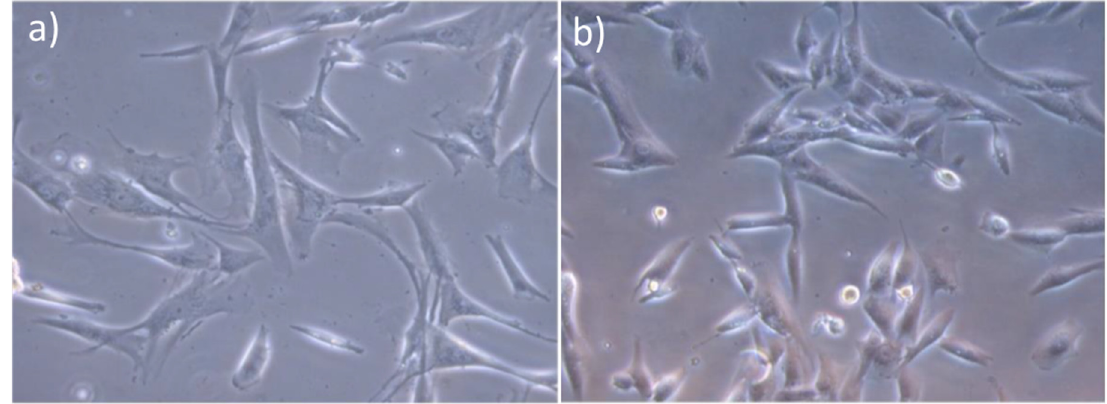
Figure 1. ( a ) hDPSCs and ( b ) MG-63 cells. 40×.